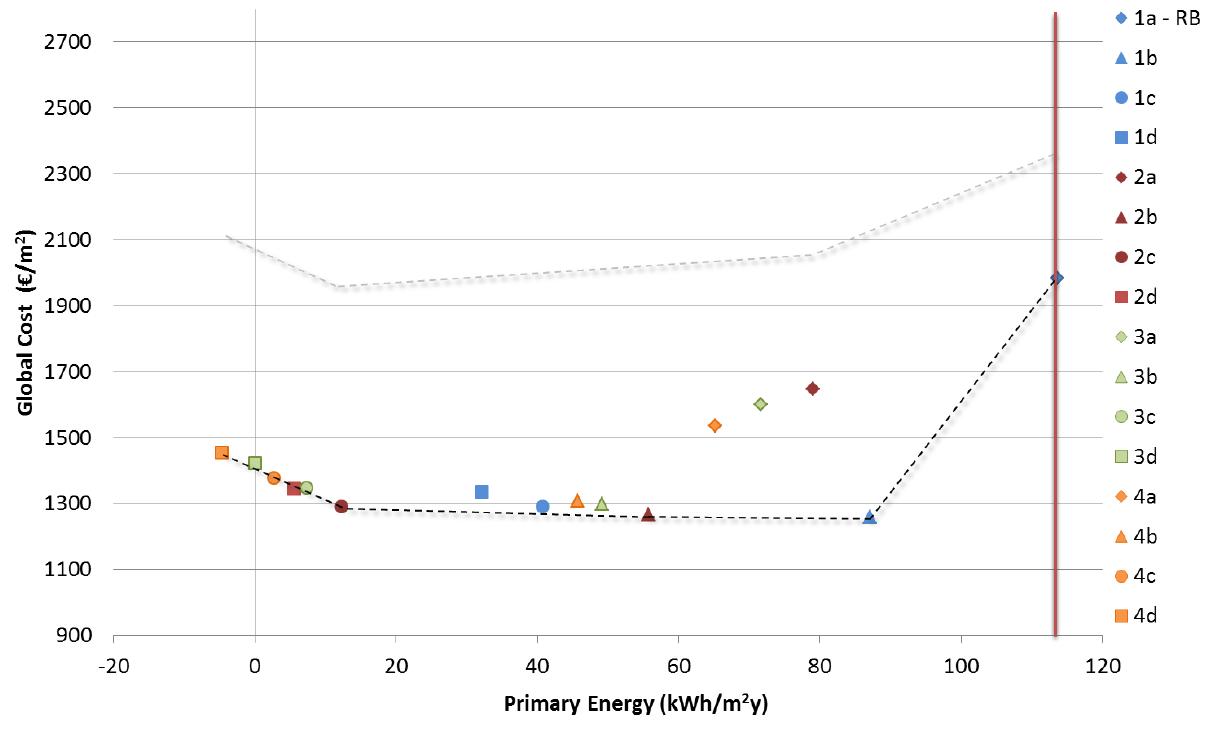
Figure 16. Sensitivity analysis with regard to tax credits in the amount of 65% of the initial investment